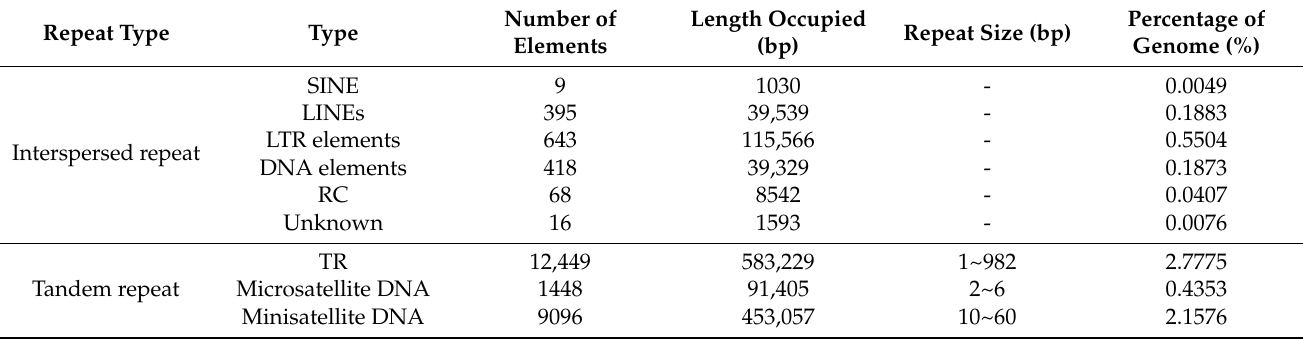
Table 3. Statistical results of repeat sequences in the N. aurantialba NX-20